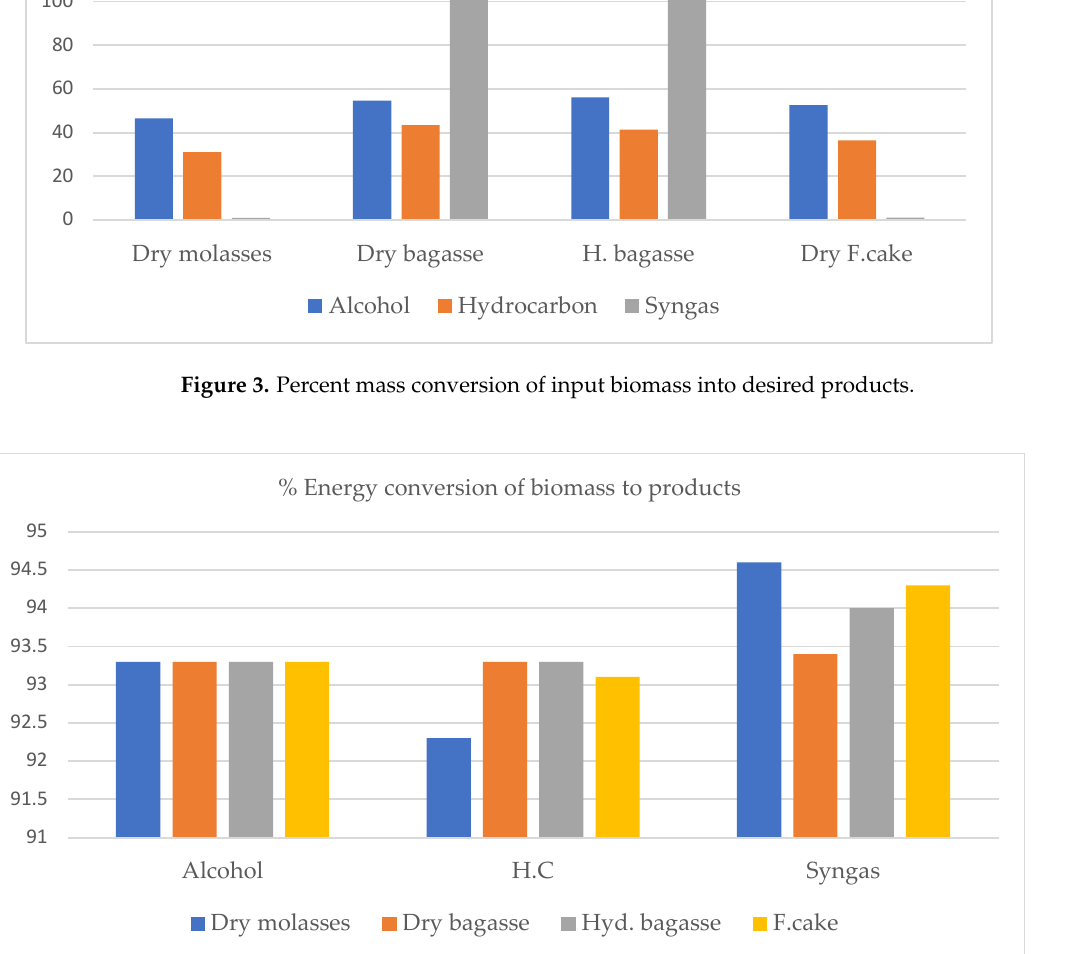
Figure 4. Percent energy conversion of input biomass into desired products.